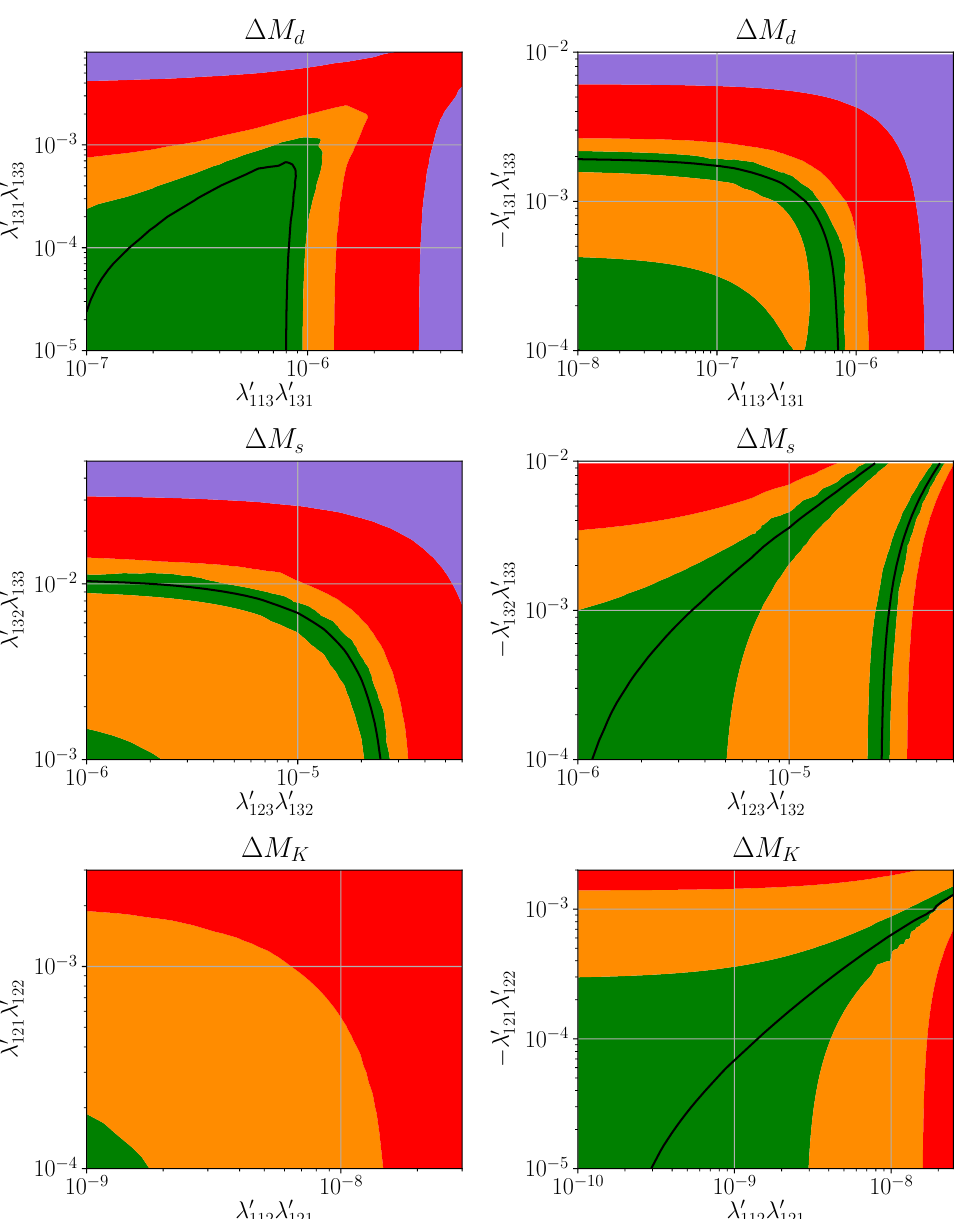
Figure 8. Limits from the meson-oscillation parameters on two RpV-directions of LQ (cid:22) D -type. The parameters are set to the values in the third row of table 1, with slepton/sneutrinos of 1 TeV. As in the previous plots, the color code re(cid:13)ects the level of tension between our predictions and the experimental measurements.